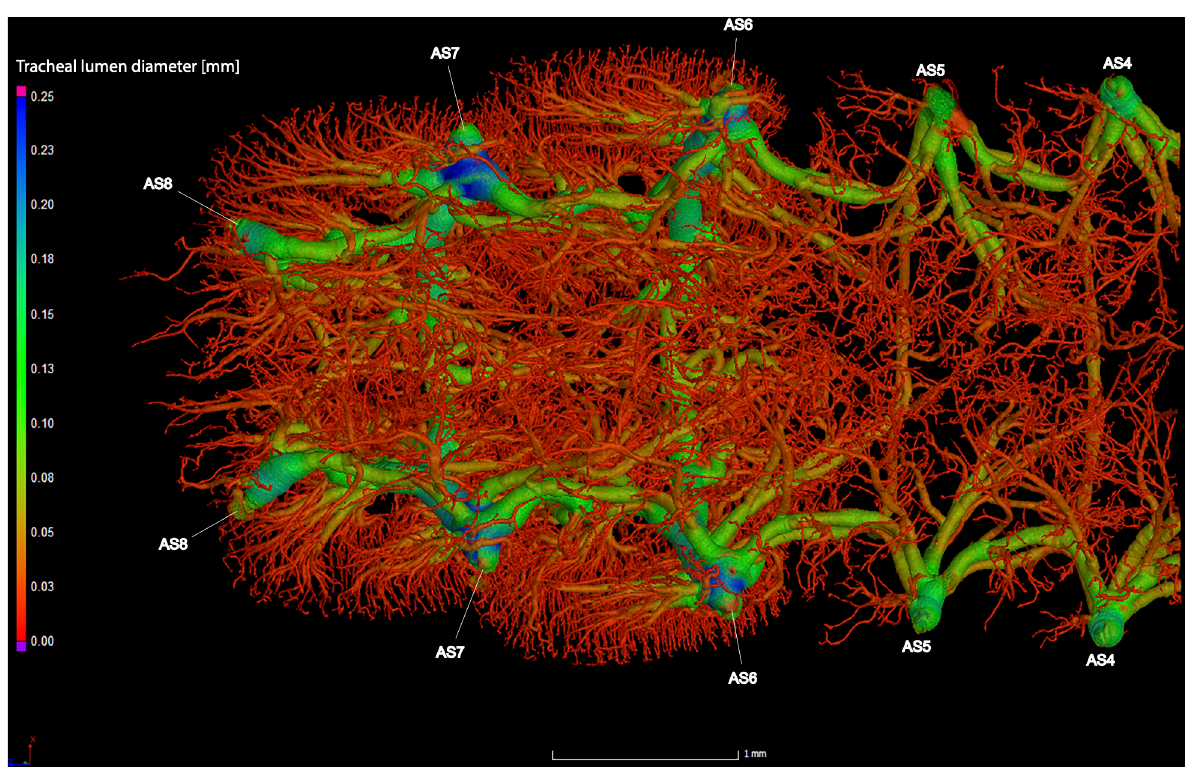
Fig 9. Dorsal view of the abdominal tracheal system in adult male Photinus pyralis .